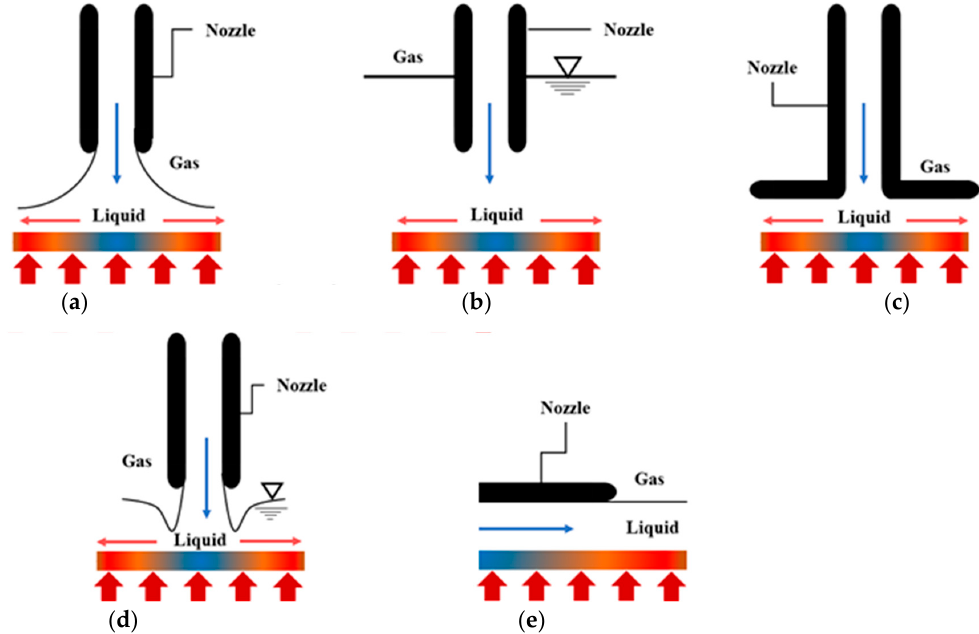
Figure 4. Type of jet impingement system used by researchers which consists of ( a ) Free surface jet, ( b ) Submerged jet, ( c ) Confined jet, ( d ) Plunging jet and ( e ) Wall jet.